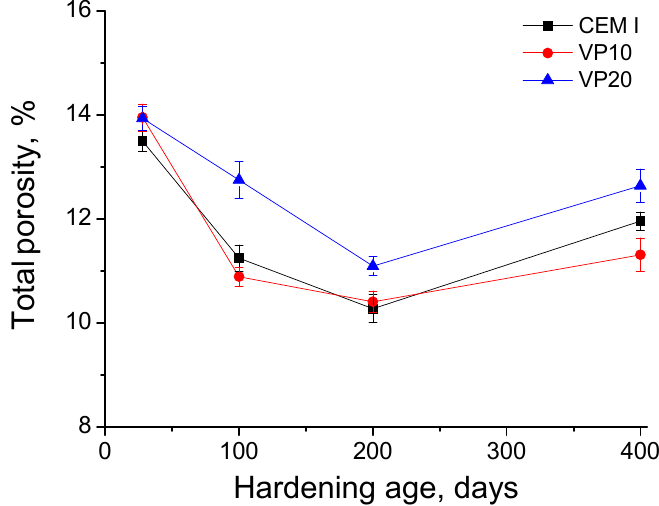
Figure 6. Total porosity of the mortars studied.